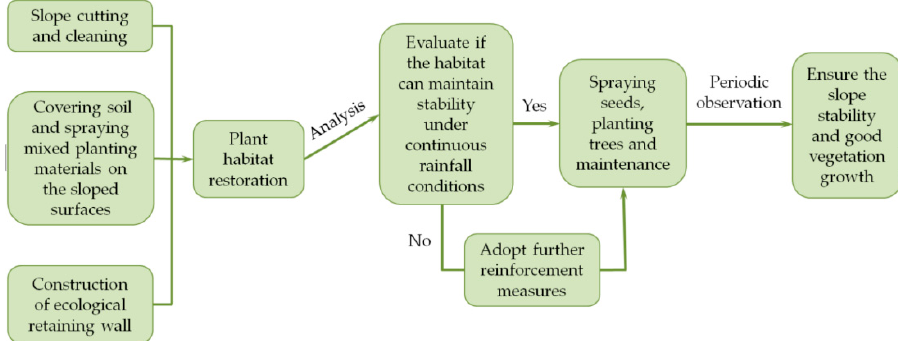
Figure 9. Ecological restoration process of abandoned island mine (Li, X [133]).